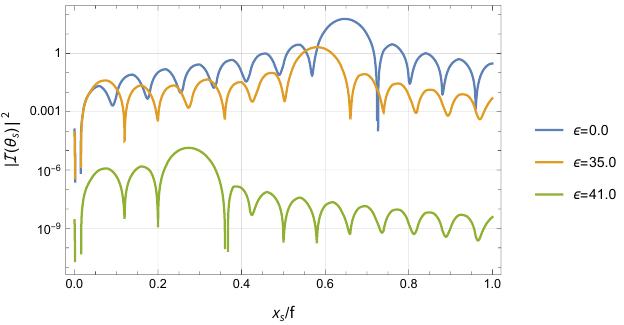
Figure 12 . The behaviour of the effective potential with respect to tortoise coordinate: V eff ( r ∗ ; l(cid:15) ) . We set r h = 0 . 3 , ω = 80 , and (cid:15) = 0 . 0 , 30 . 0 , 40 . 0 . A black solid line represents ω 2 .